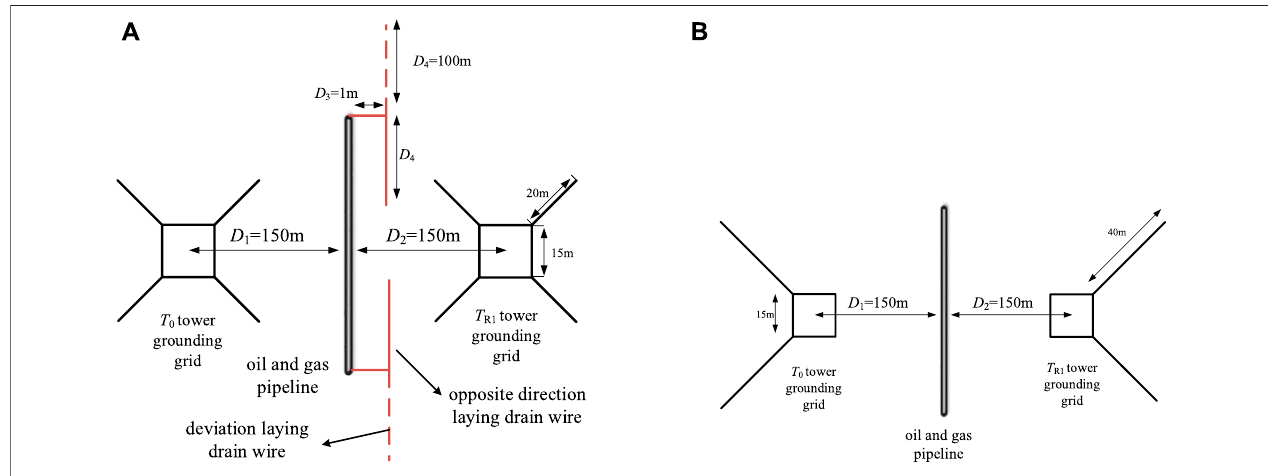
FIGURE 6 | Pipeline overvoltage protection methods. (A) shows the schematic diagram of drain wire in pipeline overvoltage protection measures. (B) shows the schematic diagram of forced commutation in pipeline overvoltage protection measures.